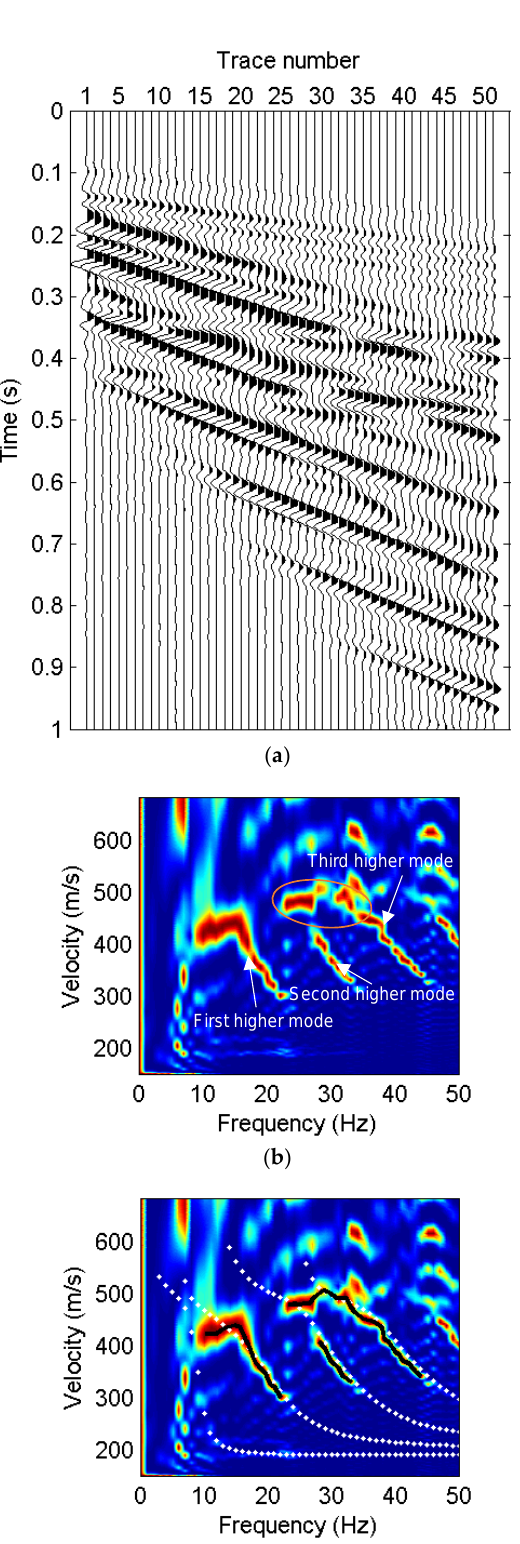
Figure 5. ( a ) A synthetic X-component shot gather of Model 4, ( b ) its image of dispersive energy in the f-v domain, and ( c ) dispersion curves picked from the dispersive energy, where the white dotted lines represent the theoretical dispersion